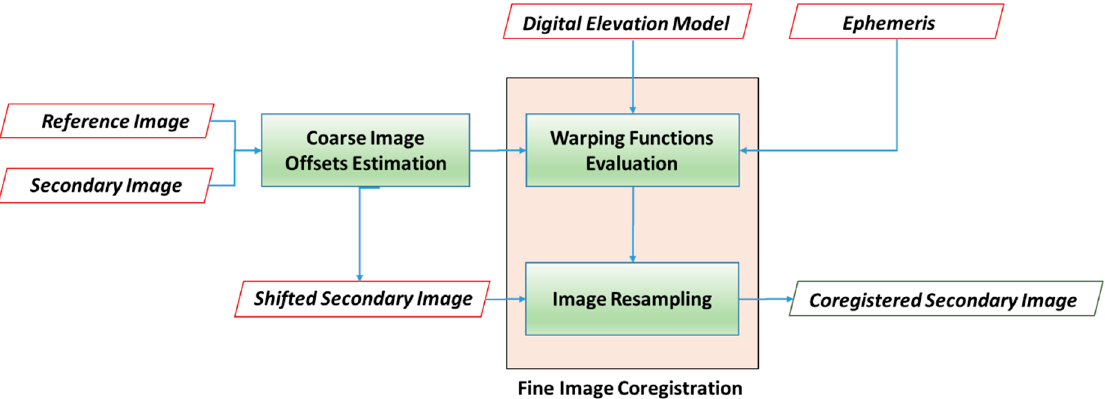
Figure 1. SAR SLC Image Coregistration Functional Scheme.